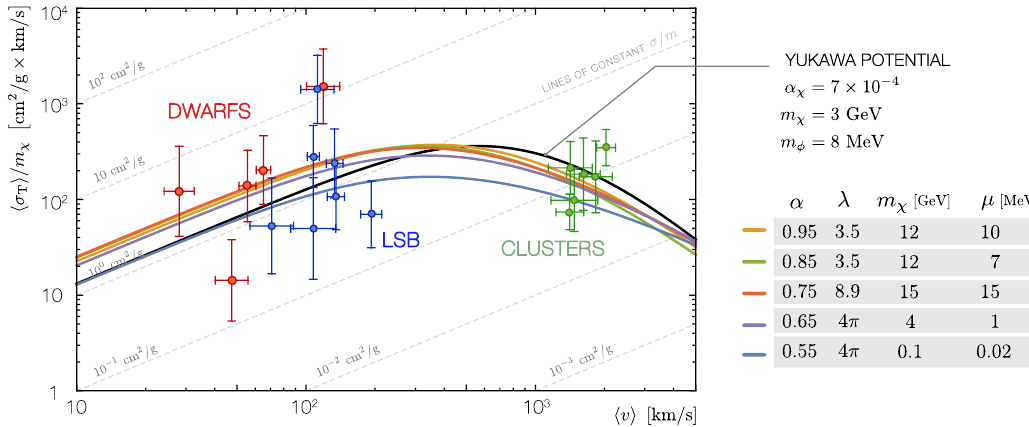
Figure 7 . Velocity dependence of the thermally averaged transfer cross section. The parameters are chosen to be reasonably fit astronomical data. A benchmark 4D self-interacting dark matter model with a scalar mediator is shown for comparison. The data points for velocities v ∼ 30 – 200 km / s are determined from the observed rotation curves of dwarf (red) and low-surface brightness galaxies (blue) respectively; points for velocities v & 10 3 km / s correspond to galaxy clusters (green) and are determined from stellar line-of-sight velocity dispersion data [62].